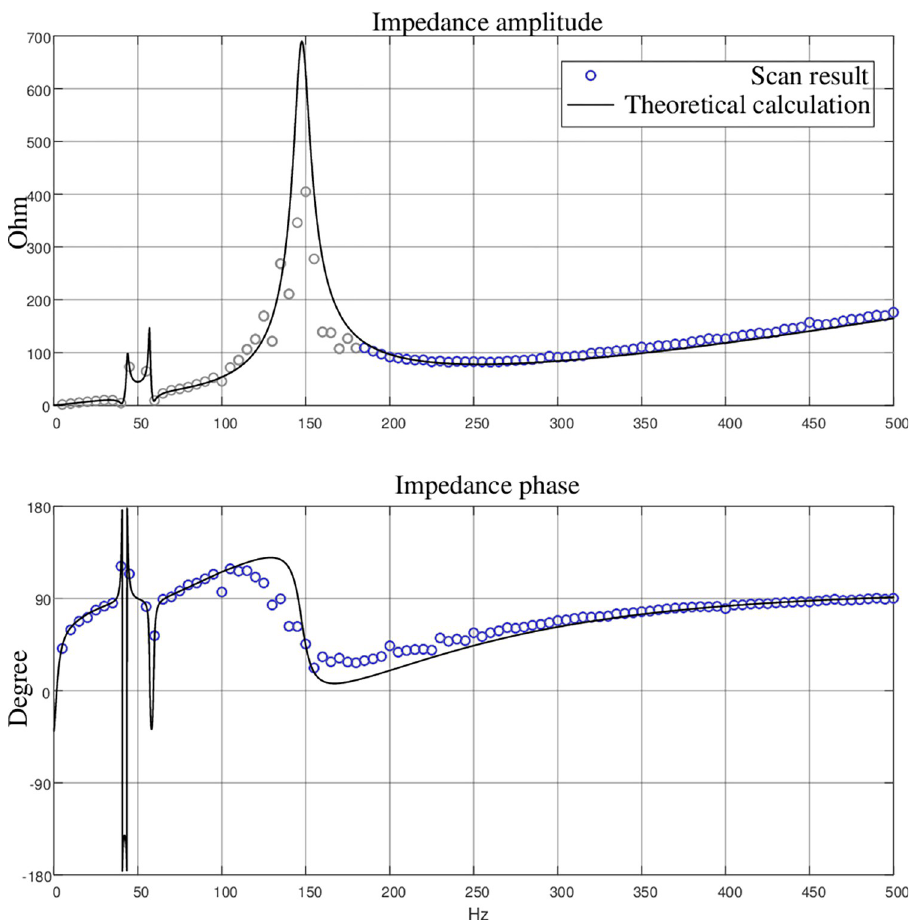
Fig 5. AC port Impedance characteristics of constant DC voltage